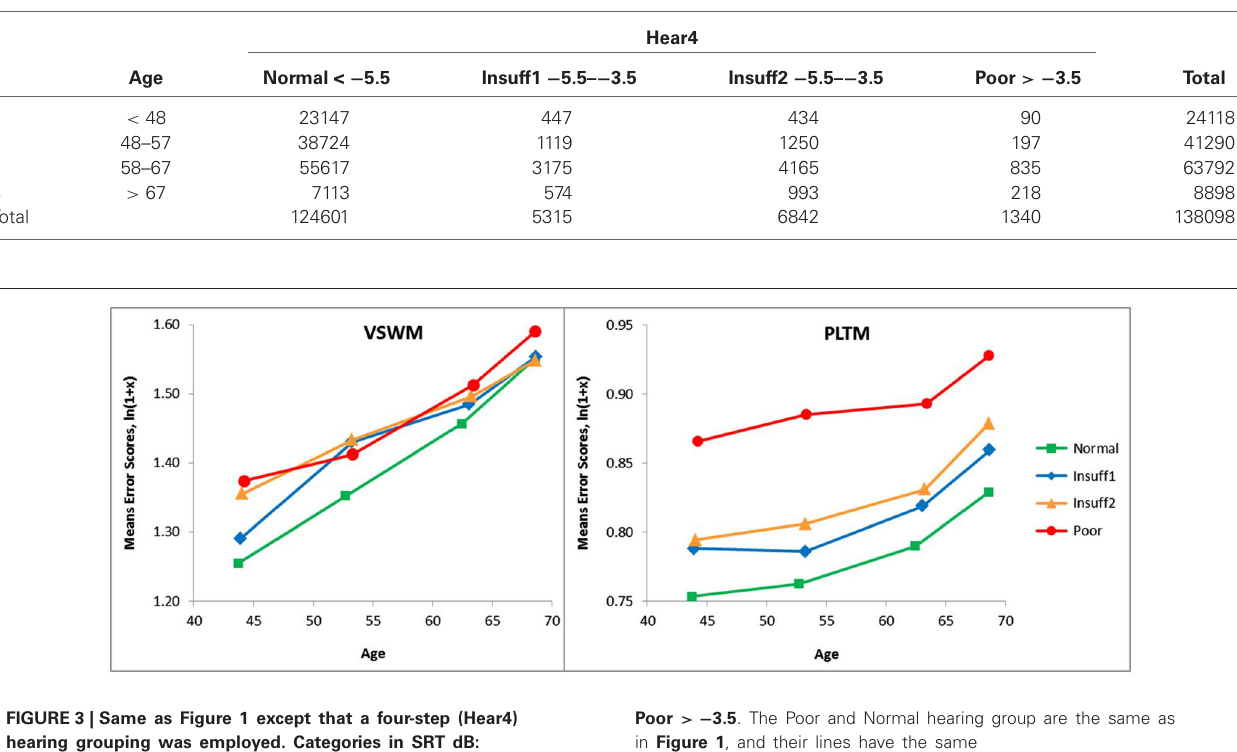
Poor > − 3.5 . The Poor and Normal hearing group are the same as in Figure 1 , and their lines have the same